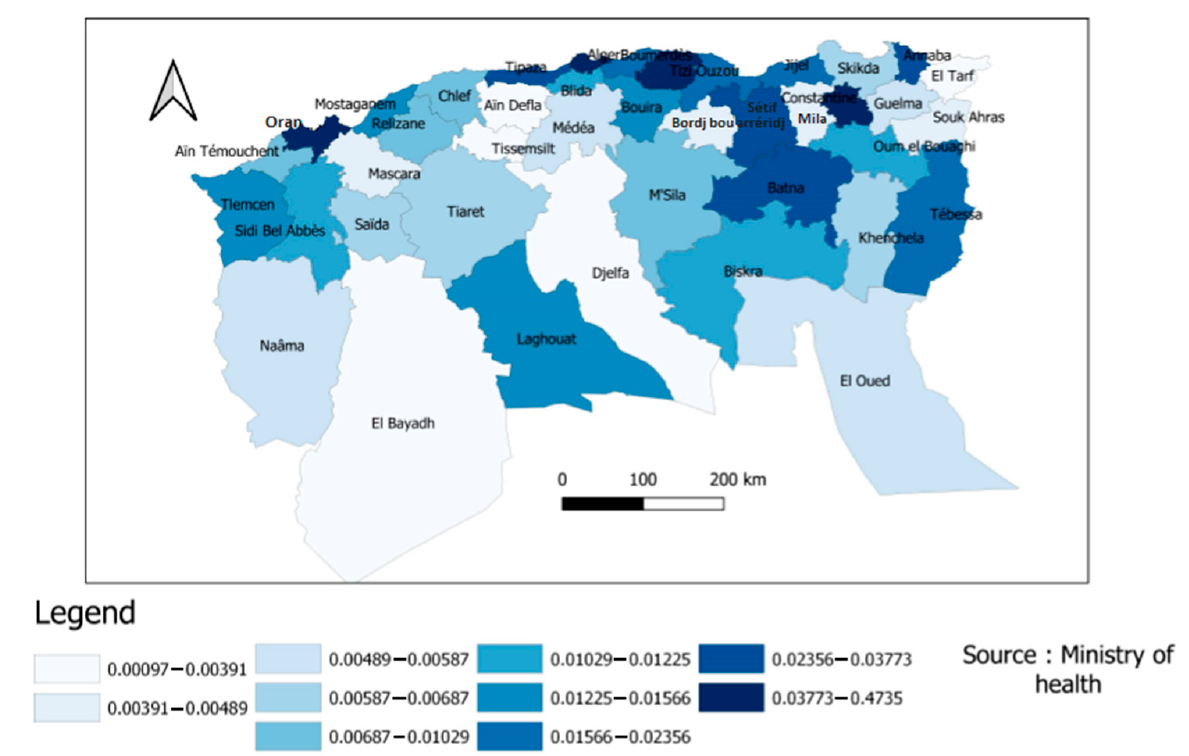
Figure 5. Distribution of COVID ‐ 19 mortality risks in the Northern provinces.